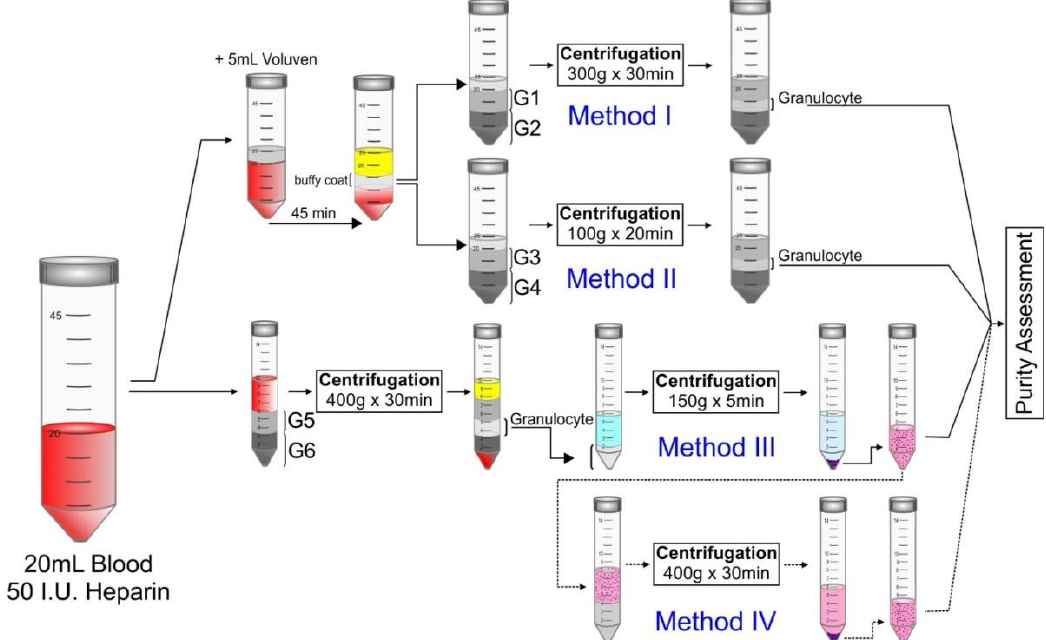
Figure 6. Schematic representation of the different granulocyte isolation methods (I-IV) tested on a blood sample for purity assessment. Method I — Granulocyte isolation with Percoll density gradients.